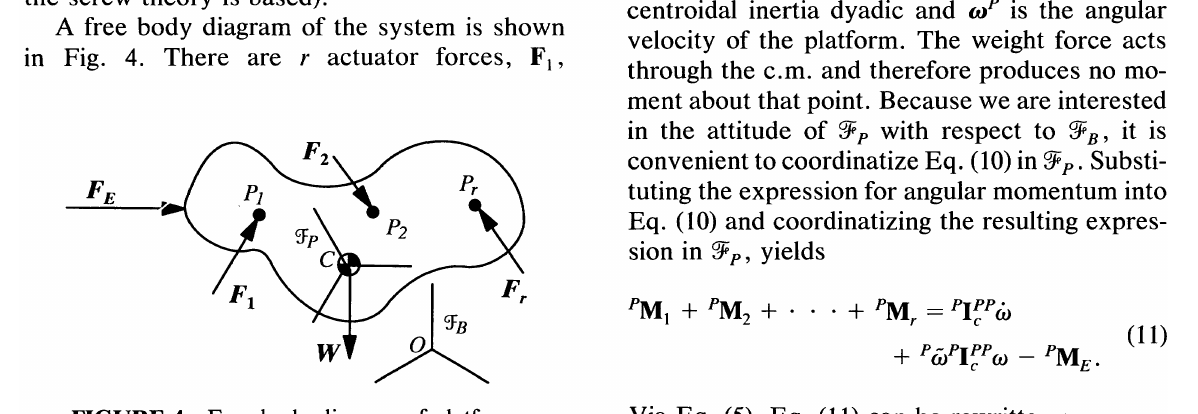
FIGURE 4 Free body diagram of